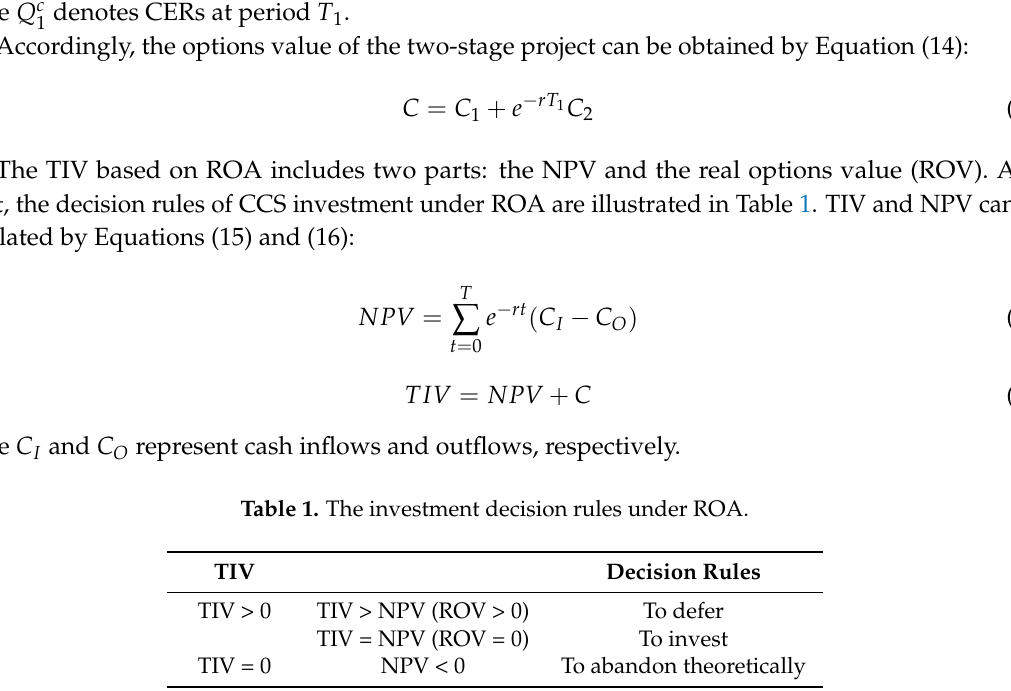
Table 1. The investment decision rules under ROA.